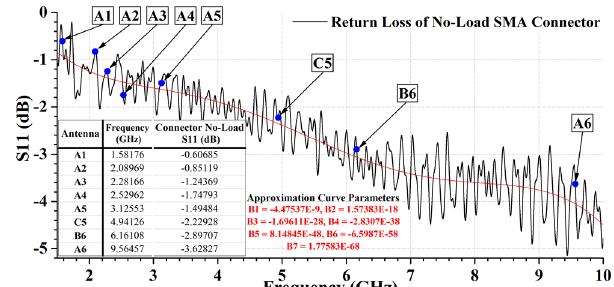
Figure. 7. The no-load S 11 of SMA connector (without microstrip antenna). The position of resonant frequency of various antennas were shown using bold blue dots. Also the associated parameters of deployed Logistic Approximation curve (red solid line) were provided too.